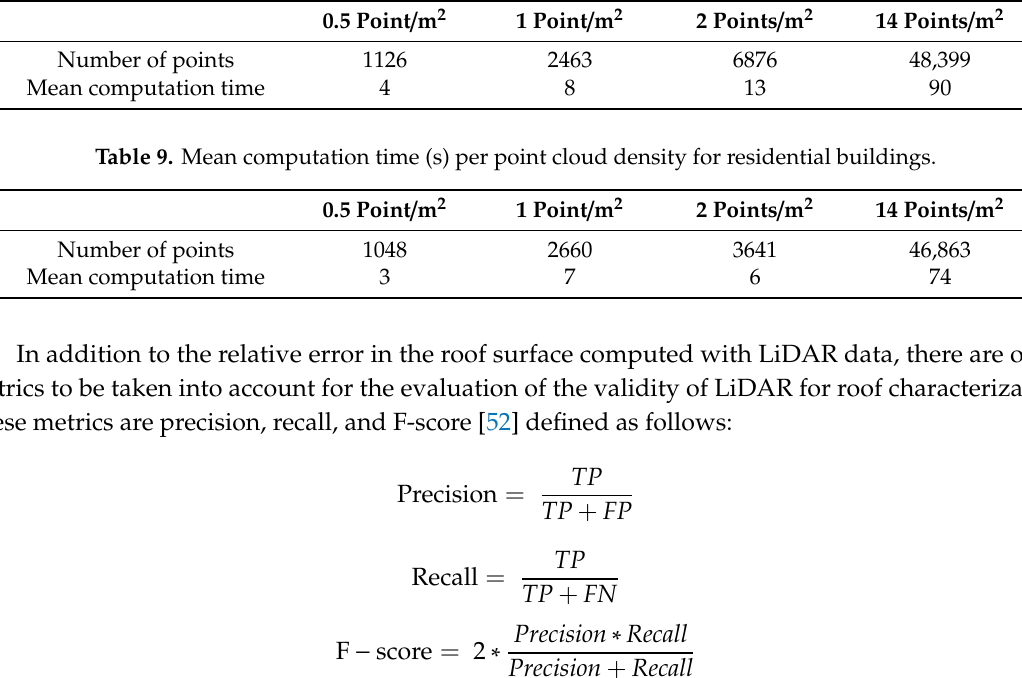
Table 8. Mean computation time (s) per point cloud density for industrial buildings.